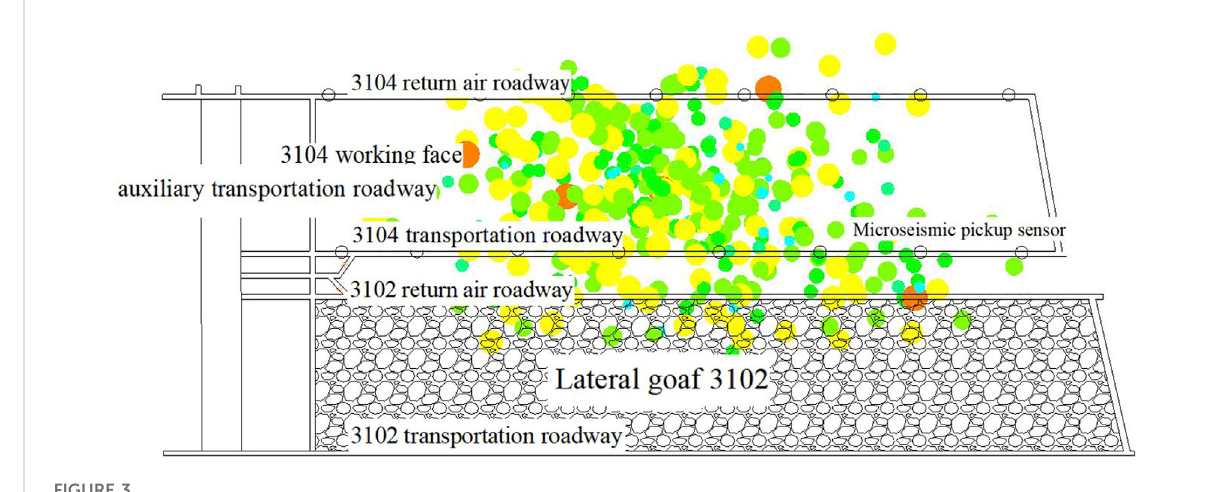
FIGURE 3 The plane distribution range of microseismic events.